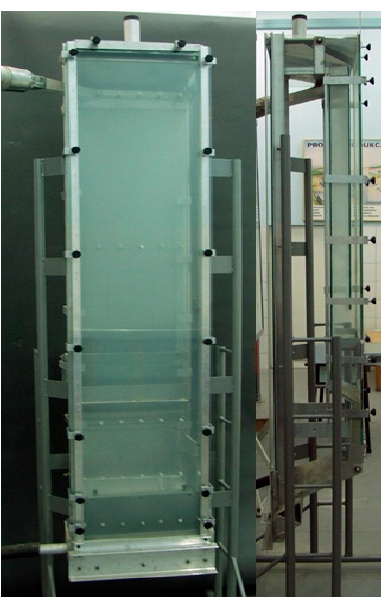
Figure 3. Fluidizing column: front view and side view.